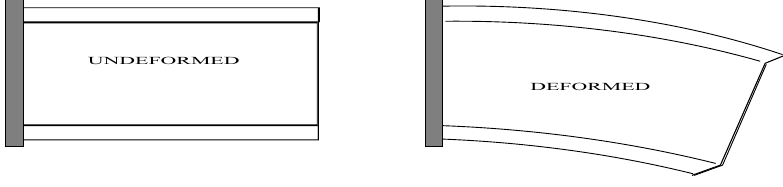
Fig. 1. Undeformed and deformed plane of a sandwich structure.